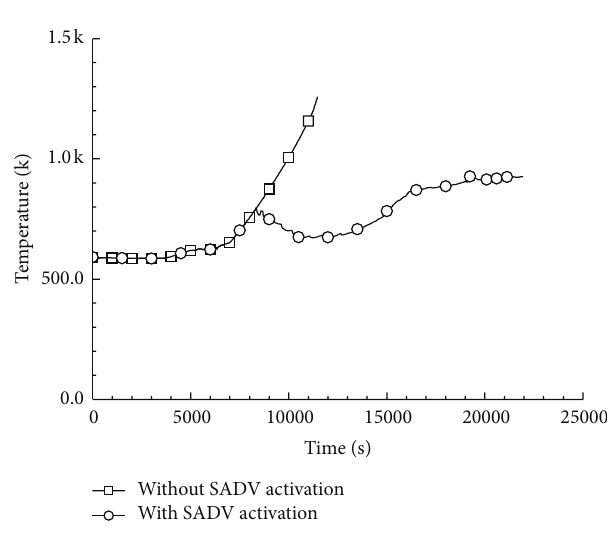
Figure 12: Wall temperature of hot